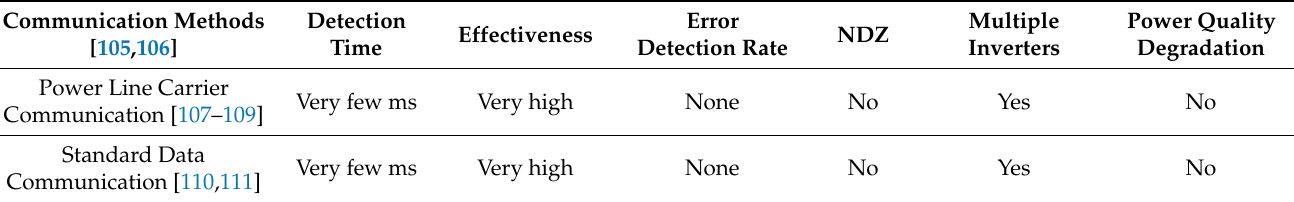
Table 4. Resume of the communication islanding methods presented in this document.